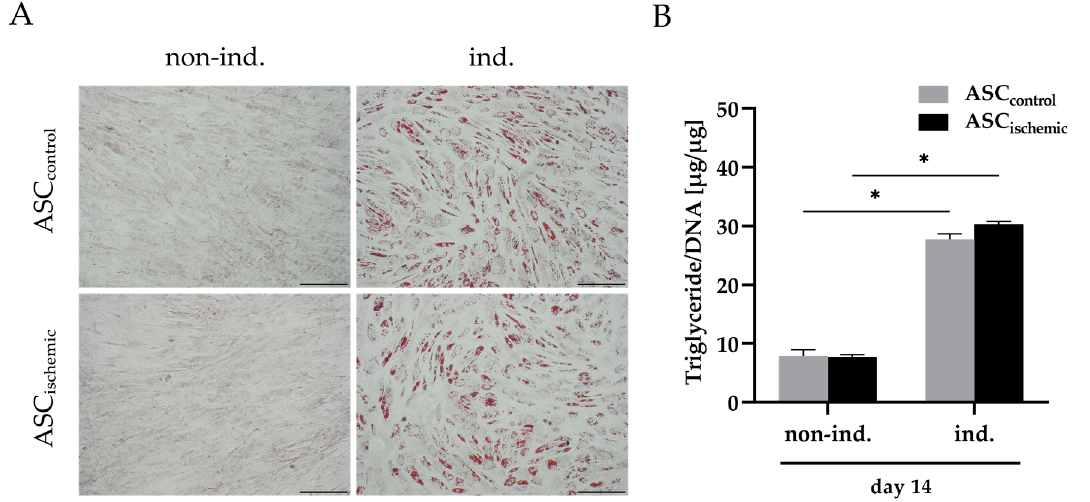
Figure 2. Adipogenic differentiation potential of ASCs after exposure to ischemia-like conditions. ASC ischemic were cultured under glucose/oxygen deprivation (0.1 g/L glucose, 0.2% O 2 ) for four days before being adipogenically induced. ASC control were cultured in growth medium before induction. ( A ) Histological analysis of adipogenesis after 14 days of induction by staining with Oil Red O (ORO, red) and hematoxylin (blue). Non-induced cells served as controls. Representative images are shown. Scale bar represents 200 µ m. ( B ) Quantitative analysis of triglyceride content. Analysis was performed at day 14. Triglyceride contents were normalized to the DNA content of the respective samples. Data are presented as means ± SD of n = 3; * p < 0.05. Abbreviation: Non-ind.: Non-induced; ind.: Induced; ASC ischemic : ASCs cultured under ischemic conditions before induction; ASC control : ASCs cultured in growth medium before induction.